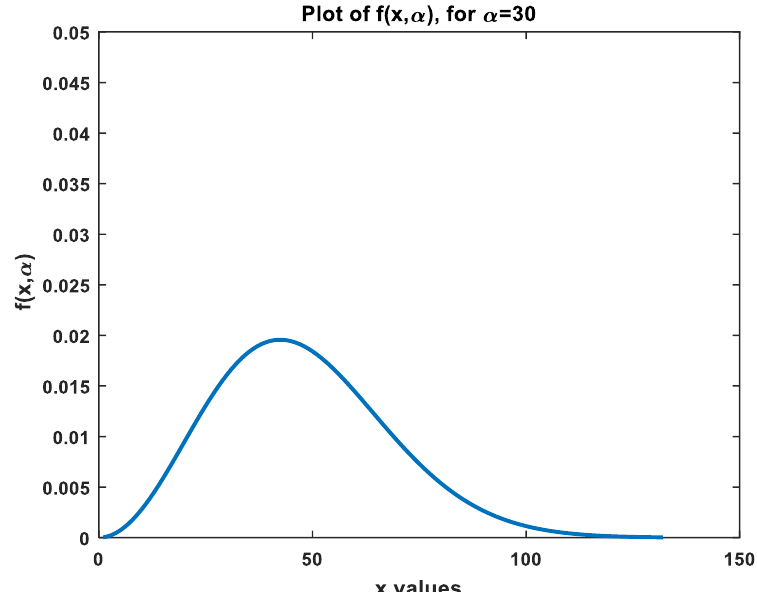
Figure-2. Maxwell-Boltzmann distribution for a value of 